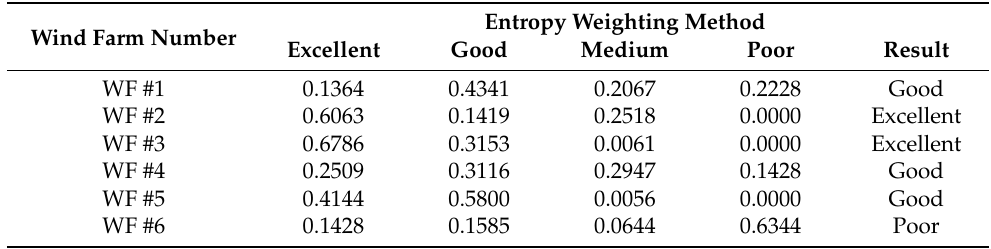
Table 9. The comprehensive evaluation results of wind farms power generation performance (entropy weighting